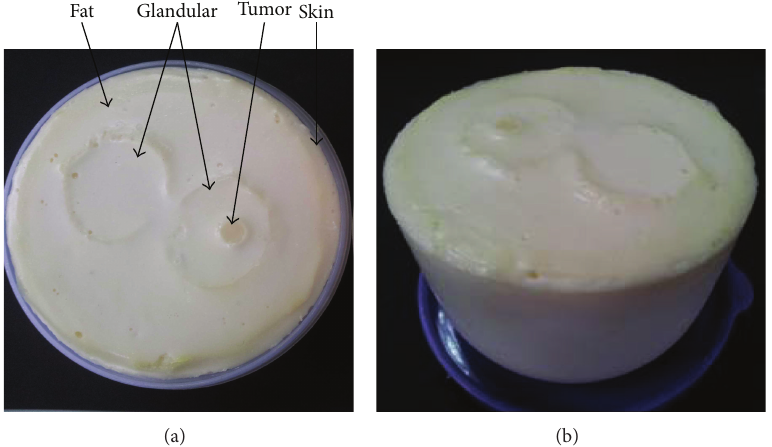
Figure 5: The realistic chemical-based heterogeneous breast phantom. (a) Top view. (b) Side view.